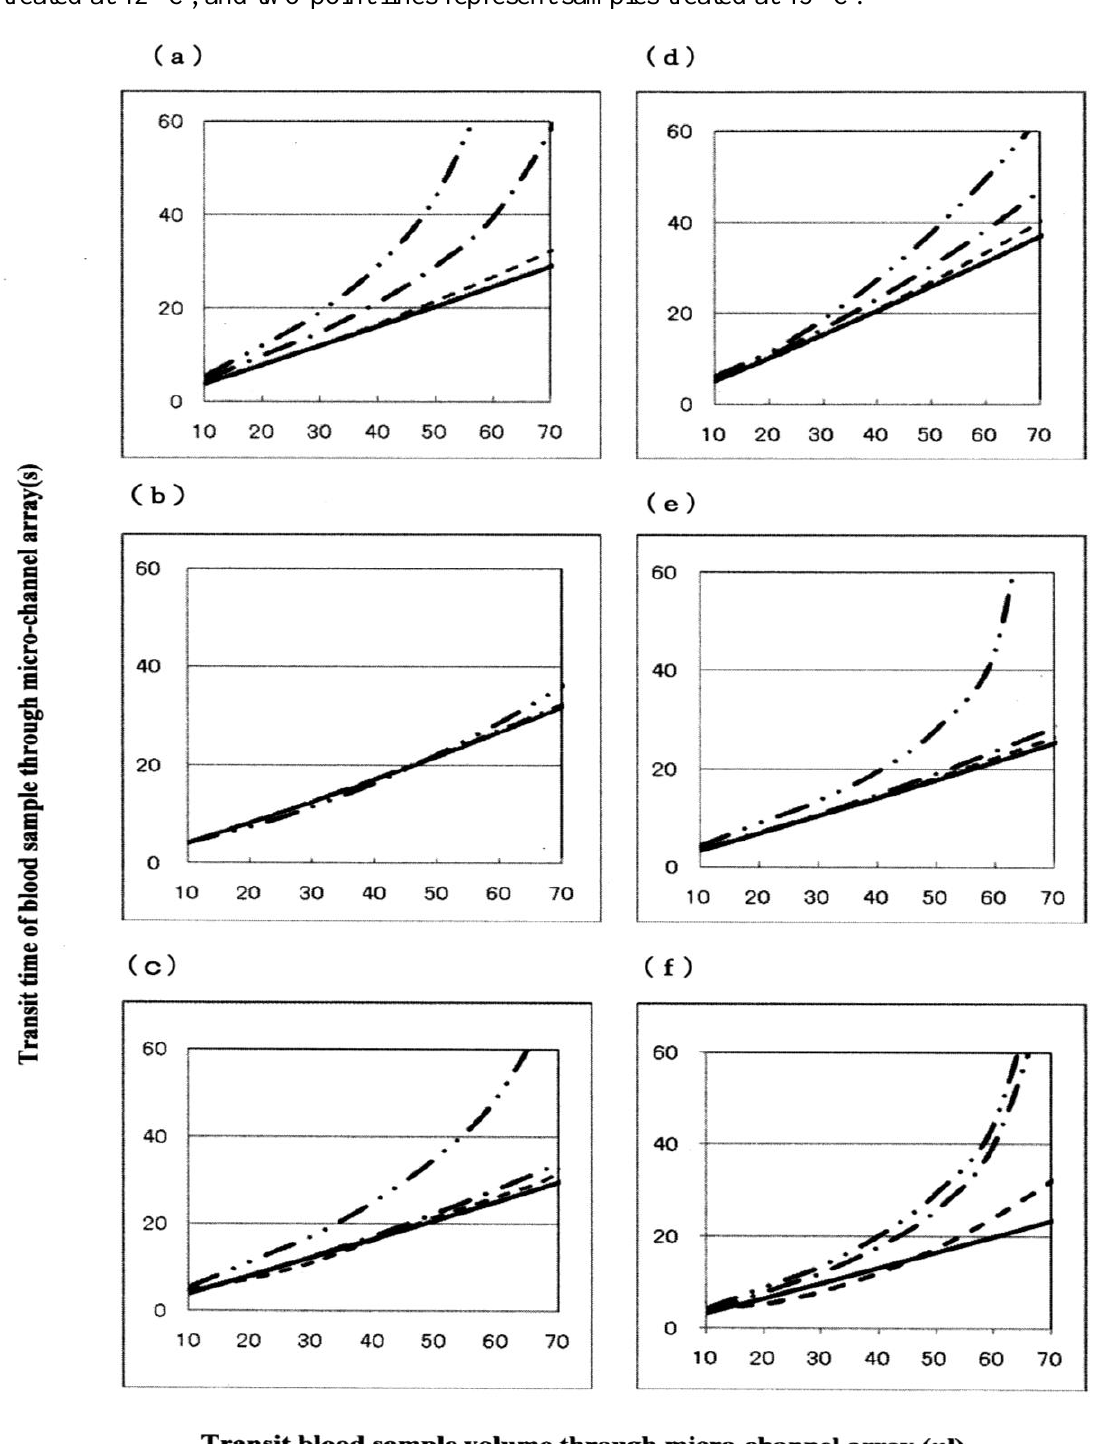
Figure 9. Blood fluidity in samples from six further donors measured in terms of transit time against transit sample volume. Solid lines represent the temperature-untreated control; broken lines represent samples treated at 37 °C; one-point lines represent samples treated at 42 °C; and two-point lines represent samples treated at 45